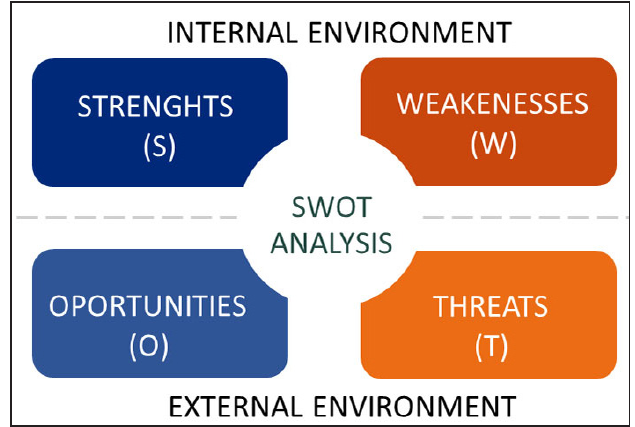
FIGURE 2 . SWOT analysis